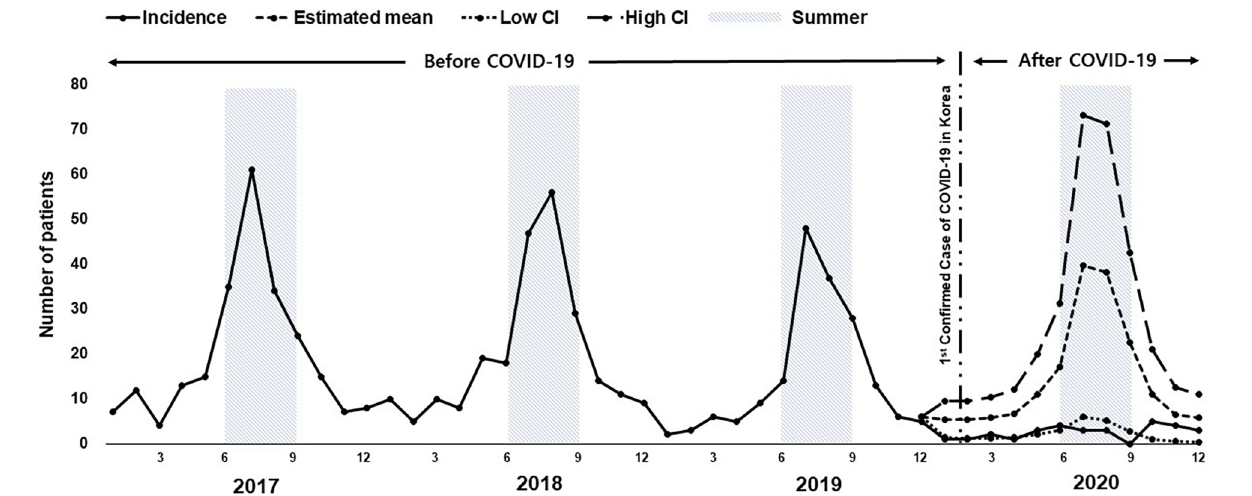
FIGURE 2 | Changes in the incidence of meningitis from January 2017 to December 2020. The solid line shows observed data. The dashed line shows the estimated value without the coronavirus disease 2019 (COVID-19) pandemic. The long-dashed line and dotted line show high and low confidence intervals (CIs), respectively (ETS [error, trend, seasonal] model). The shaded areas between June and September correspond to summer. The start of the COVID-19 outbreak in Korea is indicated by the dash-double dotted line.